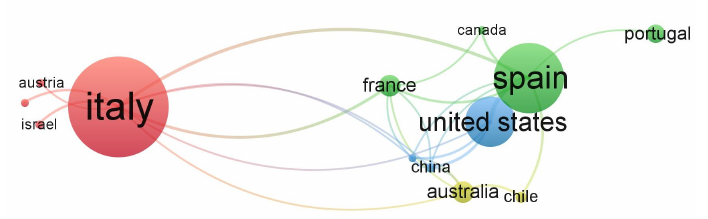
Figure 13. Network showing the co-occurrence of the keywords PV and UAVs in the world (created using VOSviewer https://www.vosviewer.com// accessed on 15 November 2021).